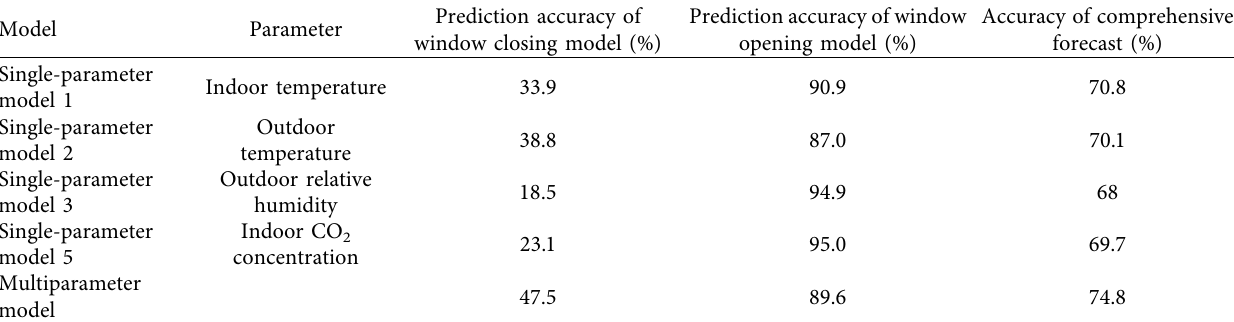
Table 8: Model prediction accuracy.